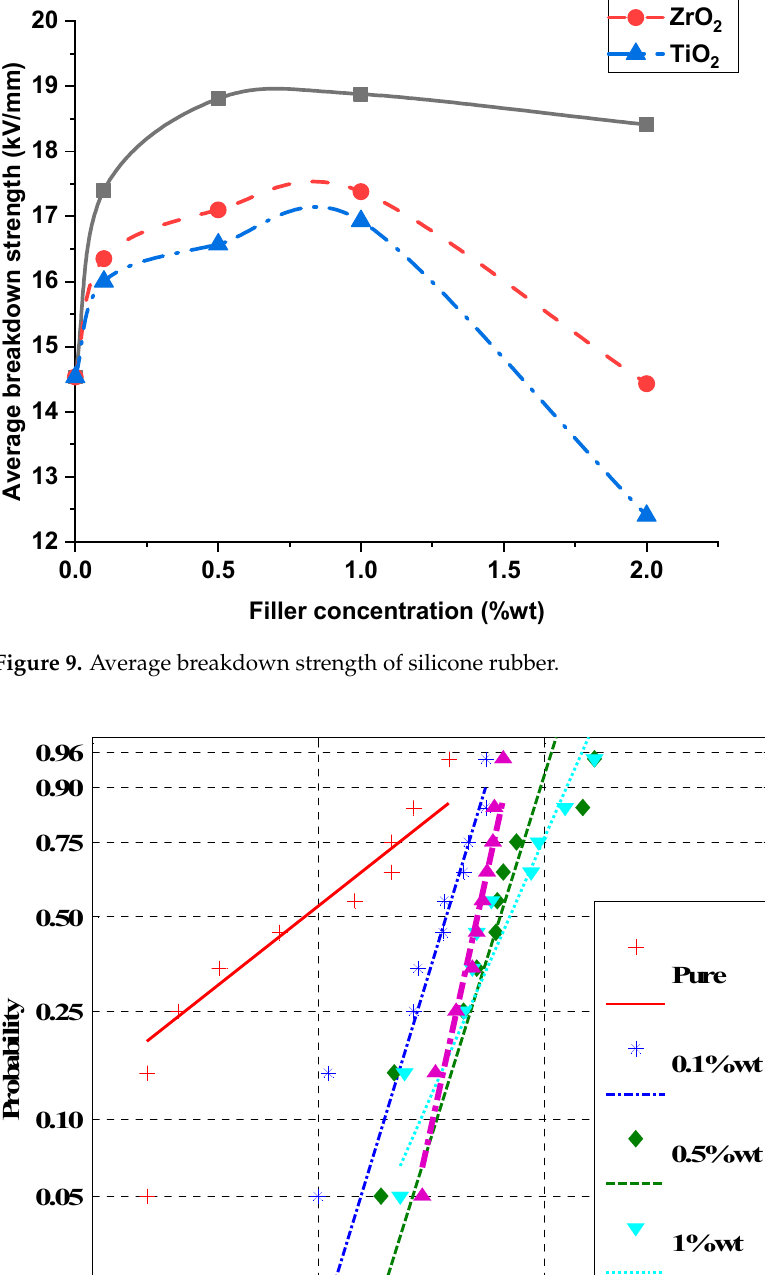
Figure 10. Weibull probability curves for breakdown strength of SiO 2 /silicone rubber nanocomposites.